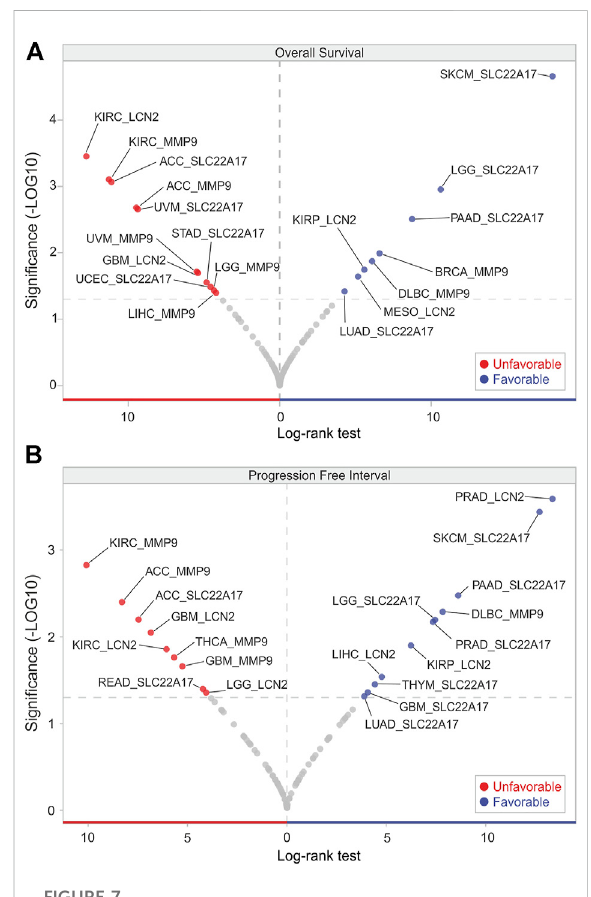
FIGURE 7 OS and PFI analyses according to LCN2 , SCL22A17 , and MMP9 gene expression. Volcano plot visualization of tumor types in which LCN2 , SCL22A17 , and MMP9 gene expression affected the patient ’ s overall survival (A) and progression free interval (B) . The genes showing signi fi cant log-rank test ( p ≤ 0.05) are represented inred(unfavorable)orinblue(favorable)accordingto their prognostic signi fi cance in each tumor